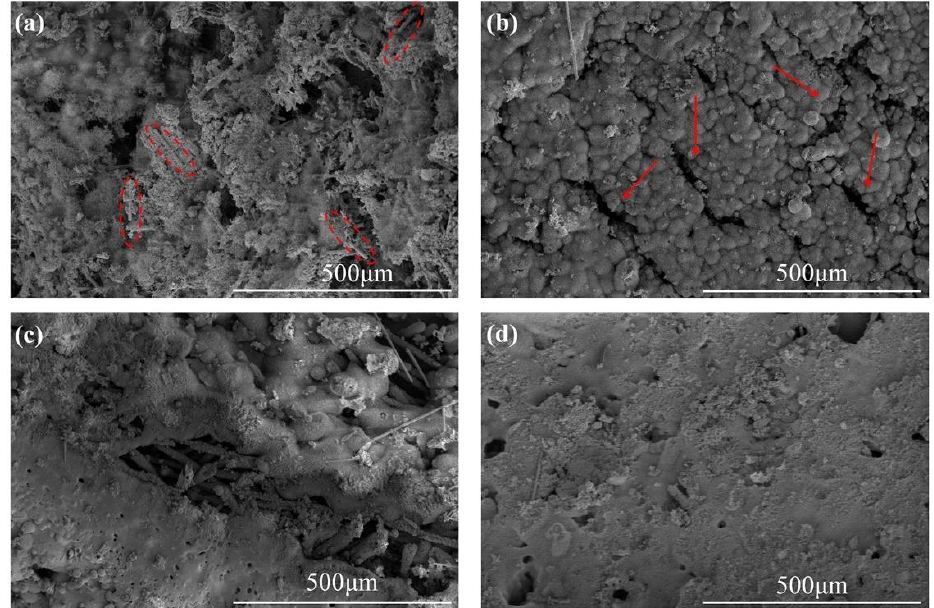
Figure 7. SEM images of the ablated surfaces: ( a ) SF-0.5; ( b ) SF-1; ( c ) SF-3; ( d ) SF-6. The red oval areas represent exposed CFs after ablation. The red arrows denote cracks after ablation.